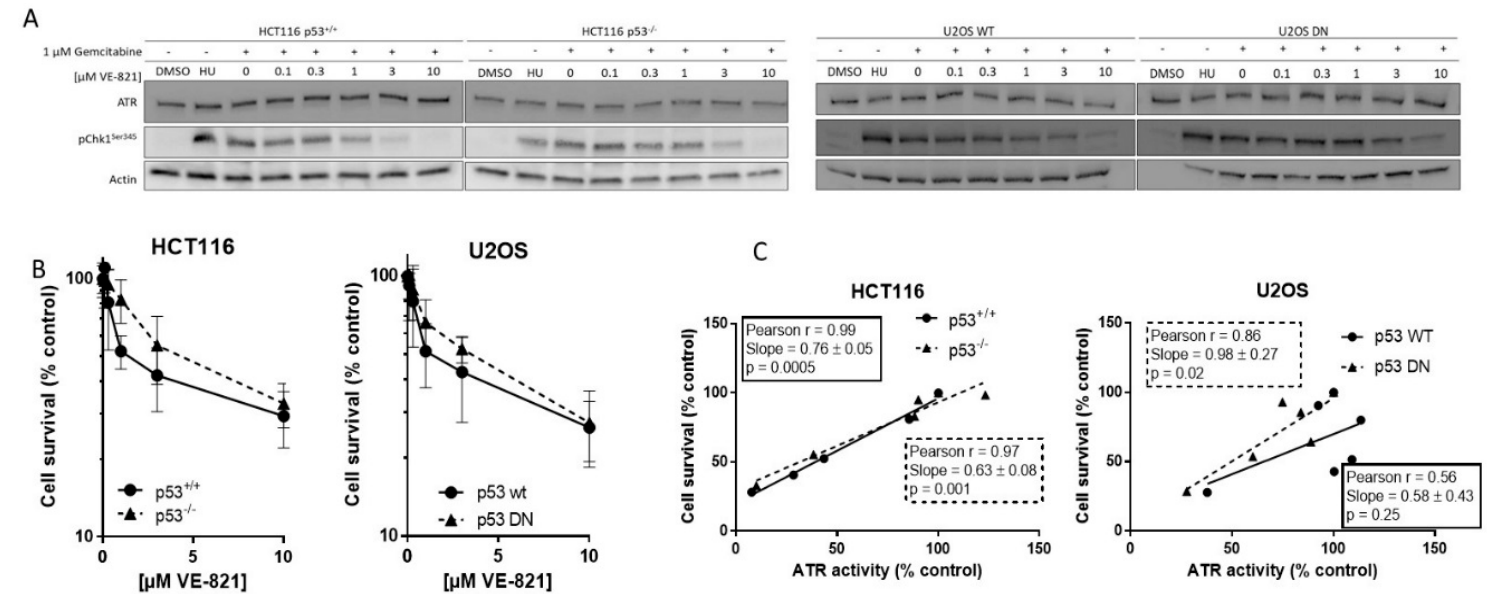
Figure 1. Activity of VE ‐ 821 as a single agent.